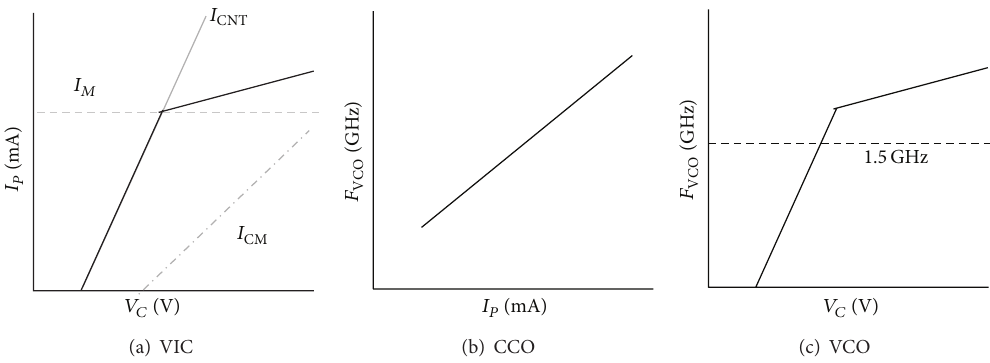
Figure 16: Explanation of the VCO with high frequency limiter [3].